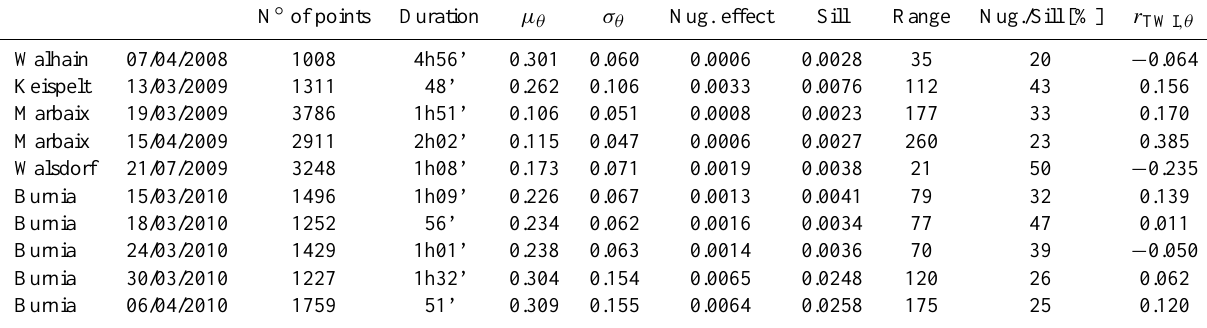
Table 2. GPR soil moisture ([m 3 m − 3 ]) acquisitions. The number of measured points, the duration of the acquisition, the mean ( µ θ ) and the nugget effect and the sill (Nug./Sill) and the coefficient of correlation between the TWI and soil moisture ( r TWI ,θ ) are